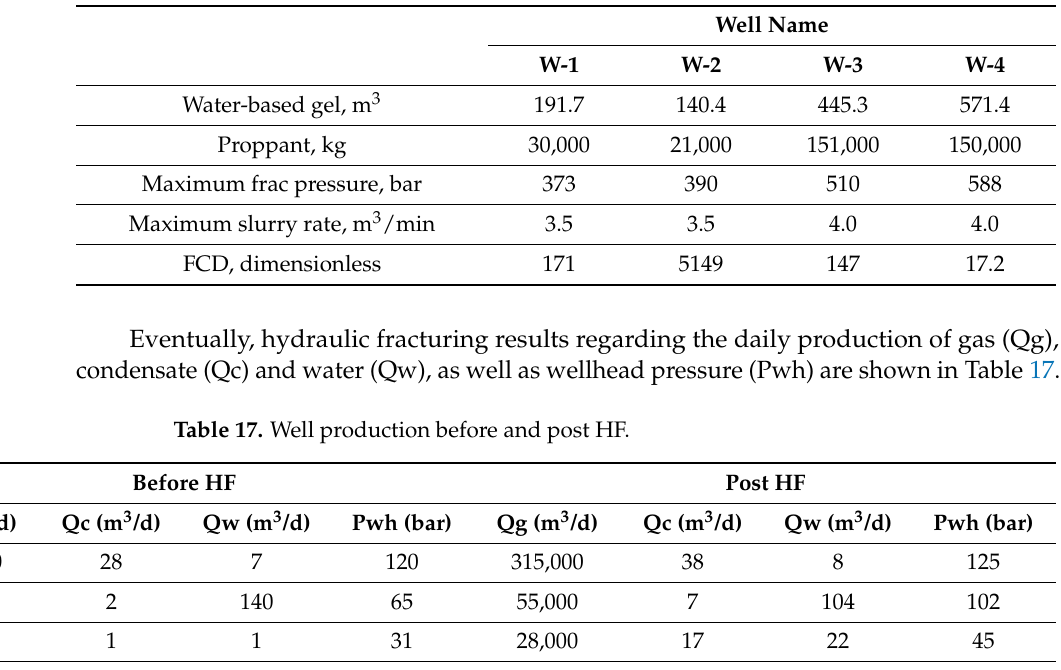
Table 16. Main hydraulic fracturing summary. FCD: fracture conductivity.